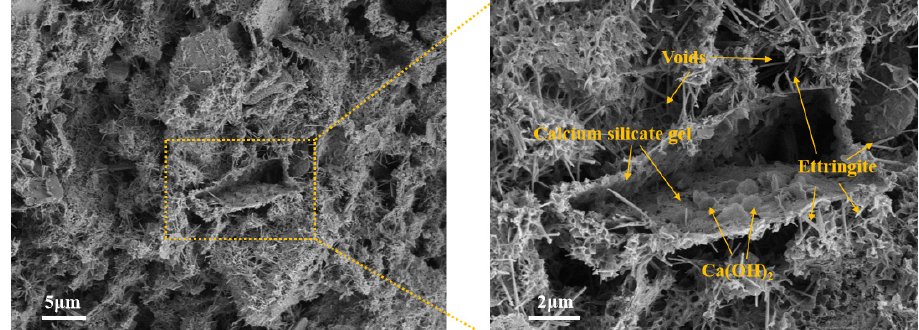
Figure 12. Microstructure of rock powder mixed with cement and lime.